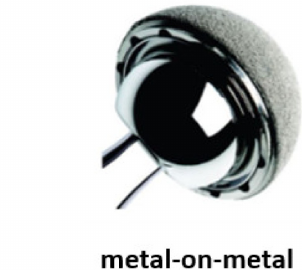
Figure 4. Materials components in hip implants. Reproduced with permission from [35]. Copyright 2003, Baishideng Publishing Group.